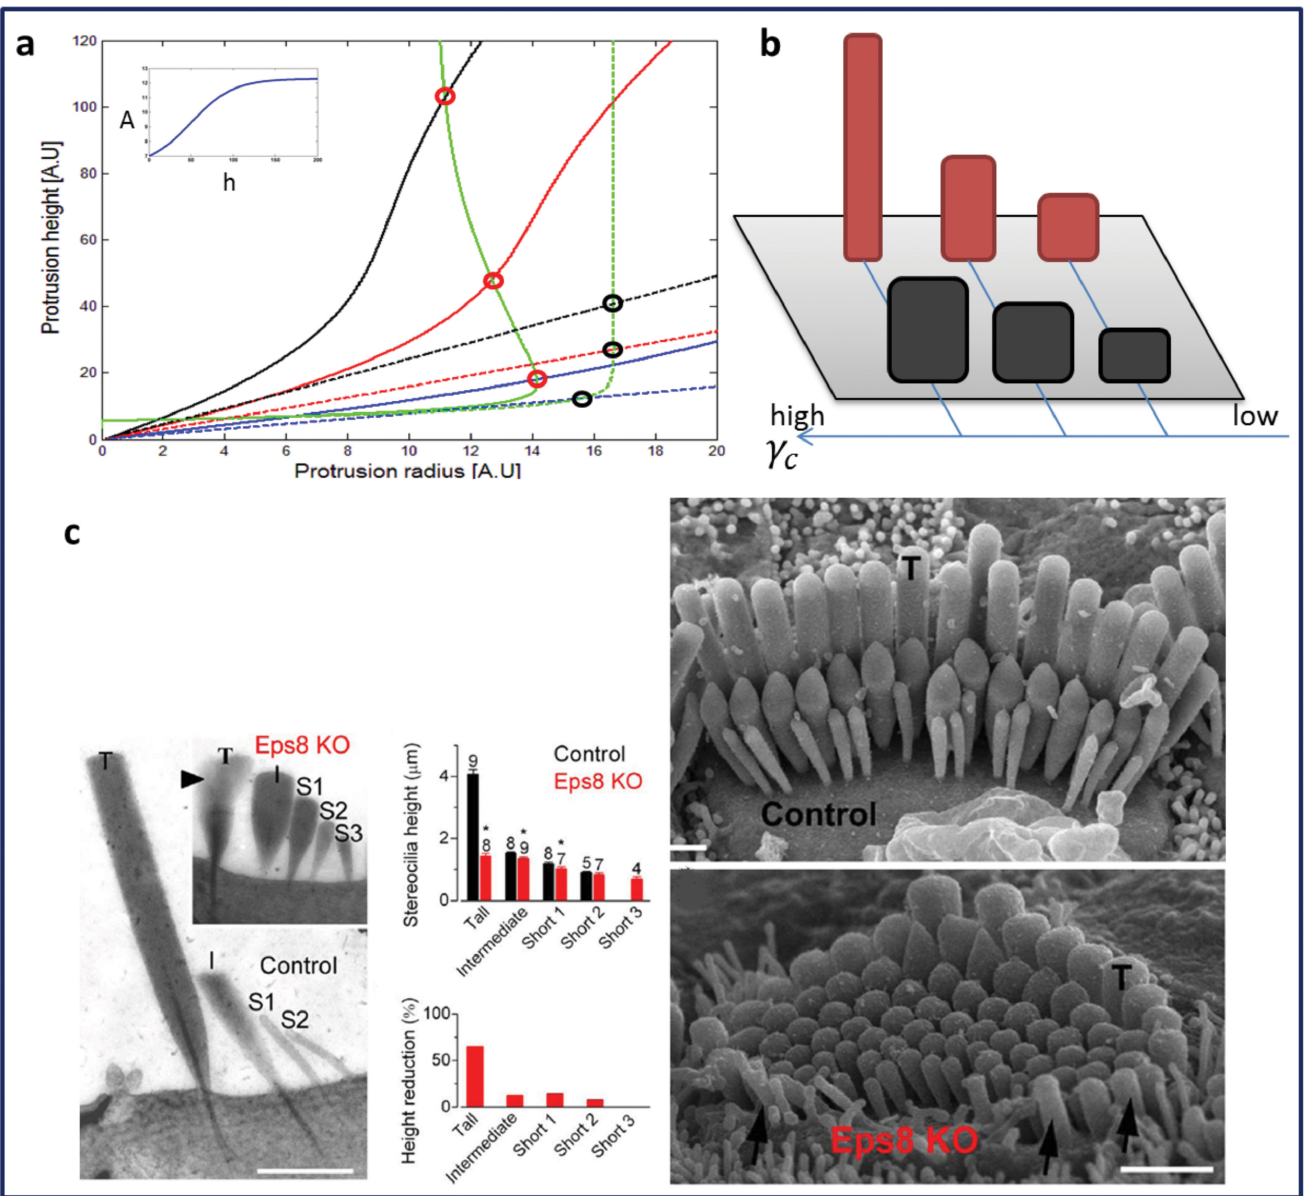
Fig 5. We demonstrate the effect of removal of the height-polymerization feedback, i.e. the increasing relation of A ( h ) on h . (a) Solid lines show the (normal) condition where A ( h ) increases with the height (as shown in the inset), and the stereocilia heights increase non-linearly (black circles, similar to Figs 3 and 4). The dashed lines show the result of reducing the polymerization rate to a constant (independent of the height), resulting in lower and thicker stereocilia (red circles). These two different SCGs are illustrated in (b).(c) Experimental results [32] comparing mammalian (mouse) stereocilia for normal inner-hair-cells, and when Eps8 is knocked out [32] (Zampini V et al. (2011) Eps8 Regulates Hair Bundle Length and Functional Maturation of Mammalian Auditory Hair Cells. PLoS Biol 9(4): e1001048.